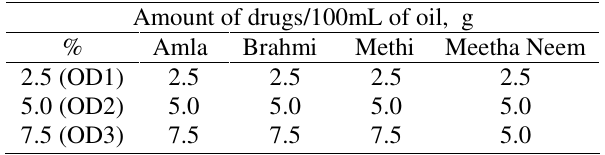
Table 1 . Selection of Concentration of Oil for Hair Growth